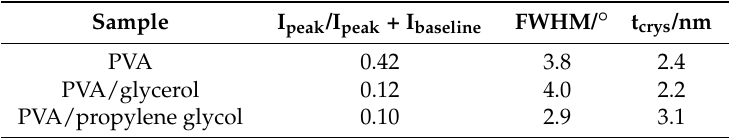
Figure 6. XRD patterns for vacuum dried, solution cast film of pure PVA-50-88 (red), with 20 wt % glycerol incorporated (black) and with 20 wt % propylene glycol incorporated (blue). Table 3. Comparison of the effect of plasticization and residual water on the glass transition and cavity radius of solution cast PVA films. Integrals and FWHM of XRD peaks for vacuum-dried films containing non-plasticized PVA, PVA plasticized with glycerol and PVA plasticized with propylene